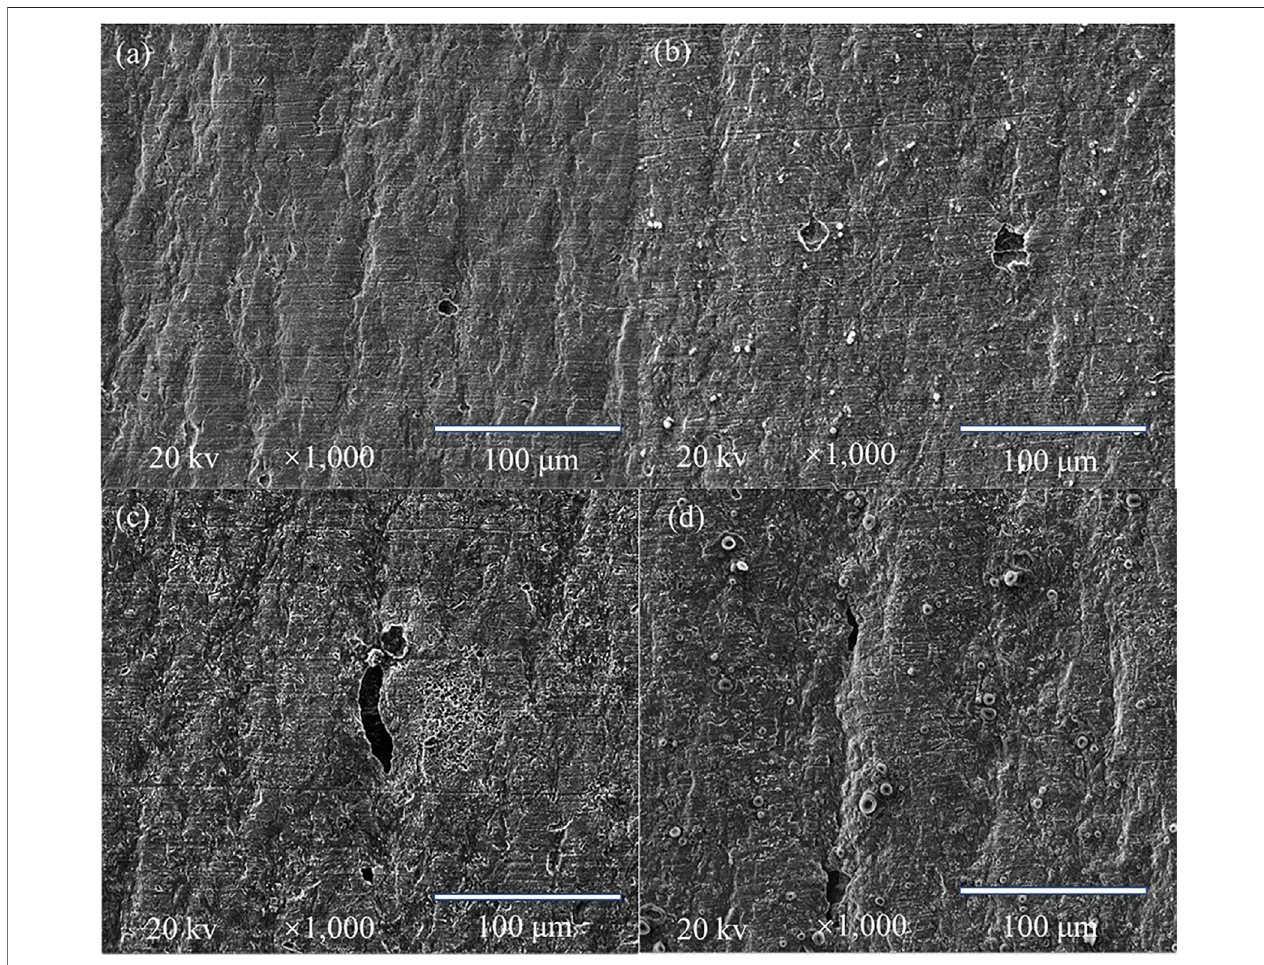
FIGURE 4 | SEM images for the X80 square coupons (with corrosion products removed) after 14-day starvation incubation in an anaerobic vial with 200 ml of D. vulgaris broth, 250 ml of headspace, and carbon source levels of 0% (A) , 10% (B) , 50% (C) , and 100% (D) .